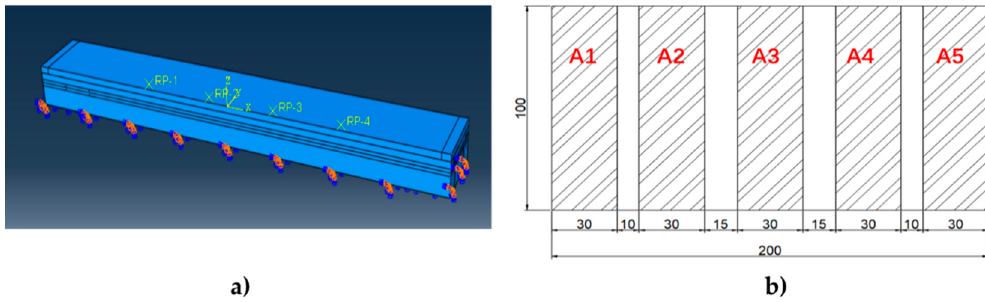
Figure 12. Equivalent wheel loading. ( a ) Load and boundary conditions; ( b ) load distribution.